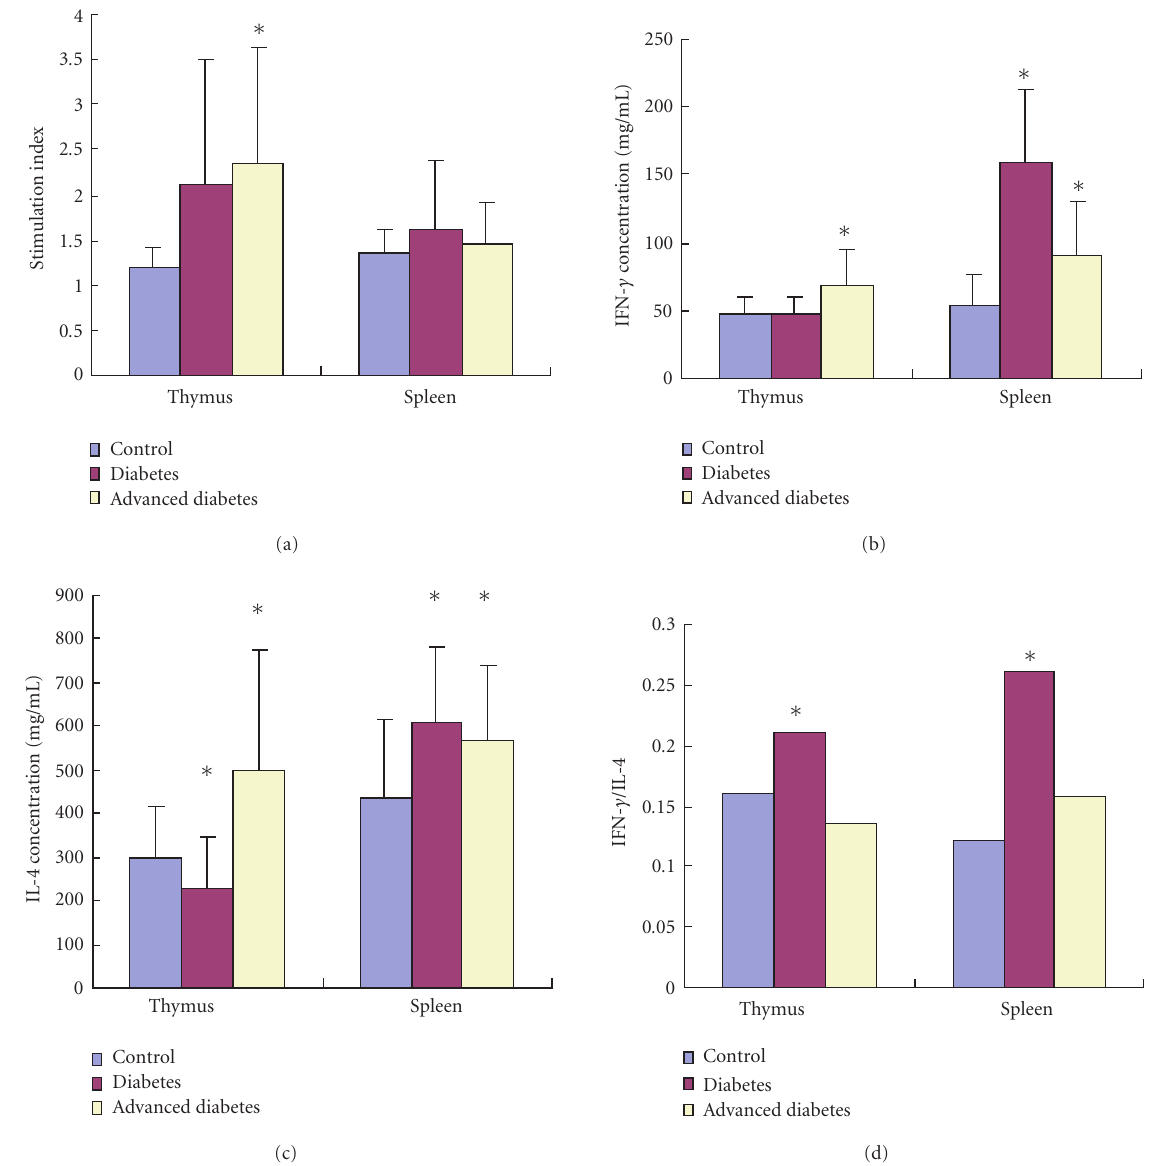
Figure 3. Spleen cell and thymus cell proliferation and cytokine secretion. (a) Spleen cell and thymus cell proliferation (assessed at 24 hours) in response to mitogen stimulation was a ff ected by STZ treatment, and the stimulation indexes in the diabetic groups are all higher than the control, though not always significant. (b) Thymocytes or (c) splenocytes were stimulated with ConA (30 µ g/mL) for 48 hours before collection of conditioned medium. IL-4 and IFN- γ concentrations following stimulation were determined by ELISA. (d) The periodic change of T H 1/T H 2 balance during disease